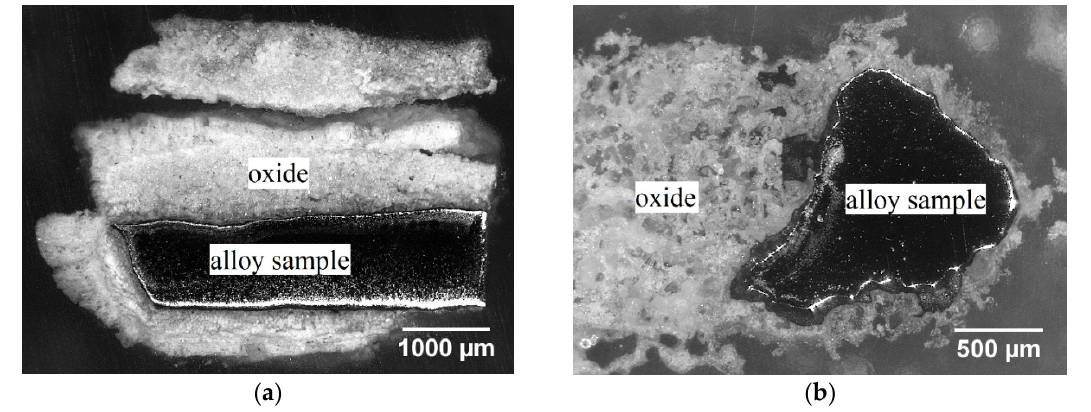
Figure 3. Optical microscope images of the cross-section of ( a ) Mo-14Hf-23B and ( b ) Mo-14.8Zr-26B alloys after cyclic oxidation in air at 800 °C for 10 h.